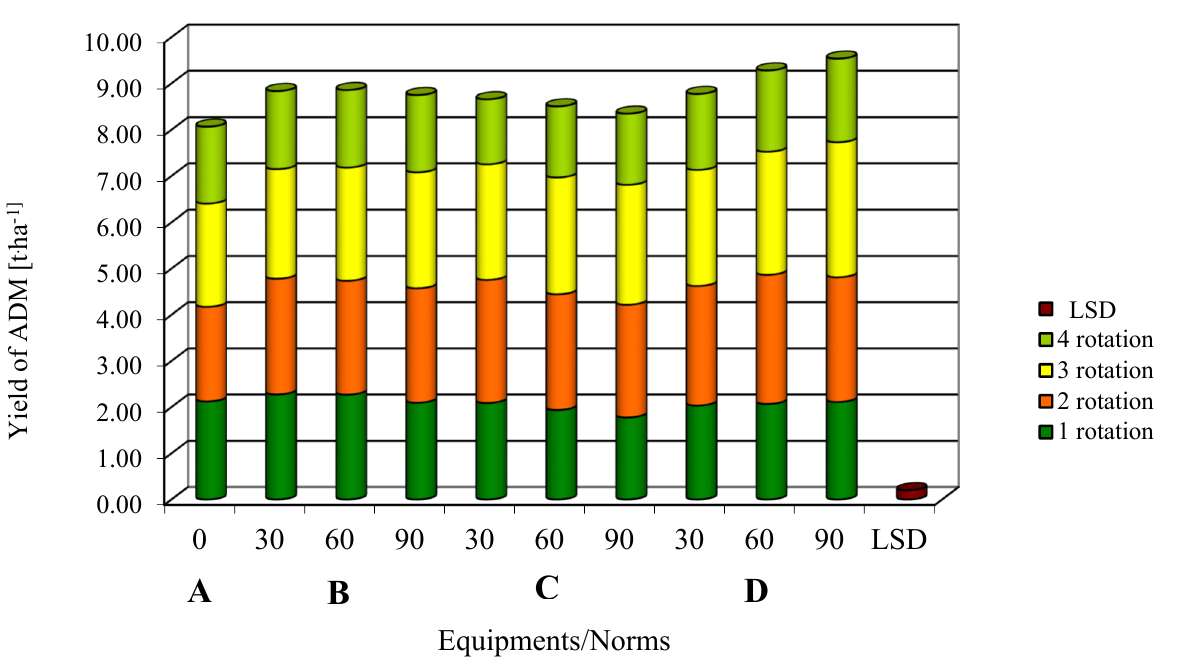
Figure 5. The influence of tillage equipment’s and norms of reseeding of T. repens in pasture rotation on the yield of ADM. Tillage treatments: A—control object (without overseeding), B—underseeding after heavy tine harrow, C—underseeding after disc harrow, D—underseeding after the rotary tiller.